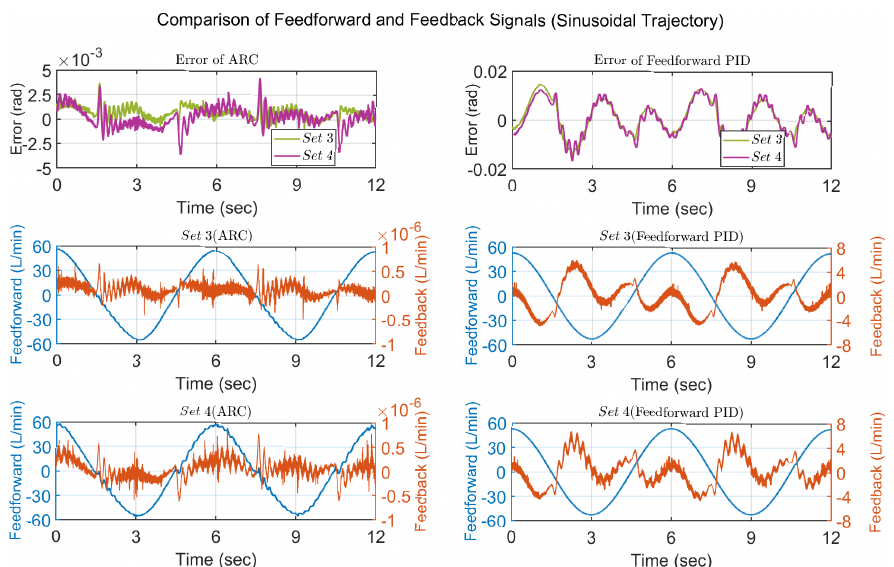
Figure 12. The comparison of feedforward and feedback between ARC and feedforward PID in the sinusoidal